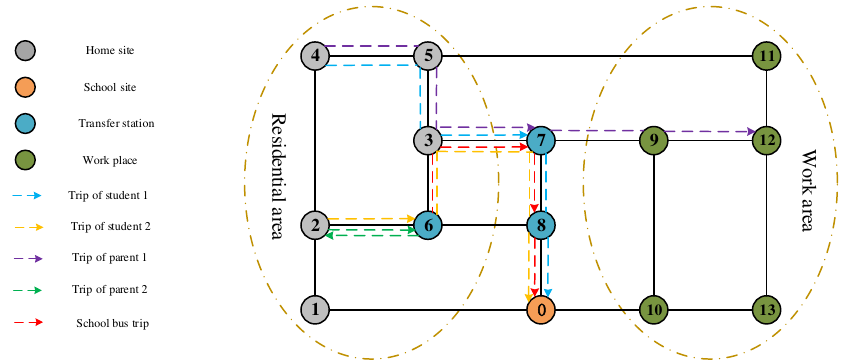
Figure 3. Network diagram of the joint-commuting model.